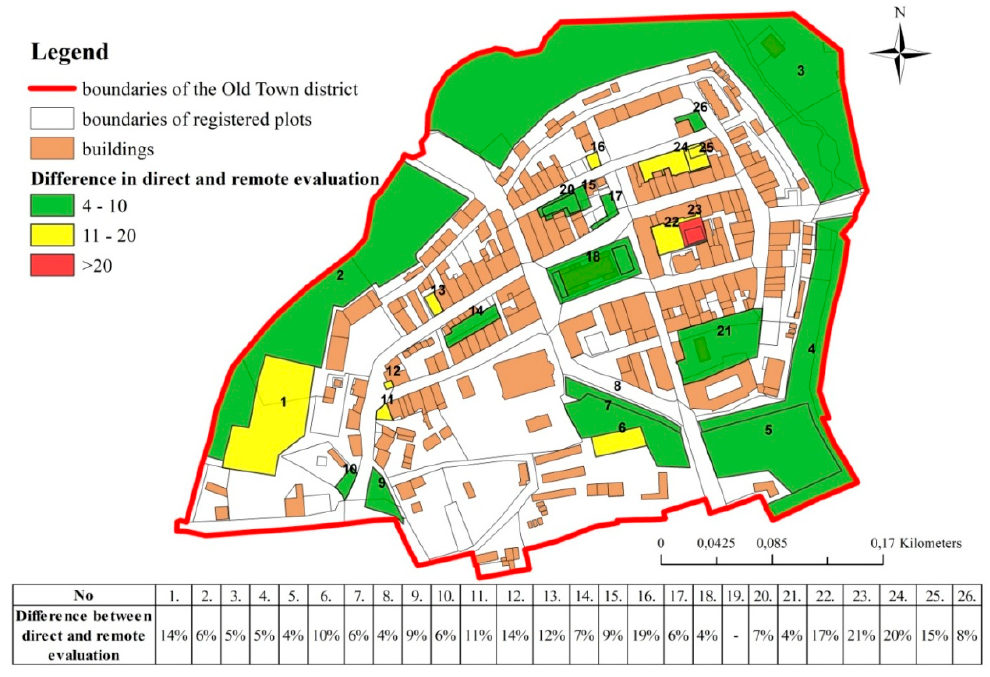
Figure 6. Average differences in the quality of public space elements evaluated in the direct and the remote approach in Orneta. Source: own elaboration.